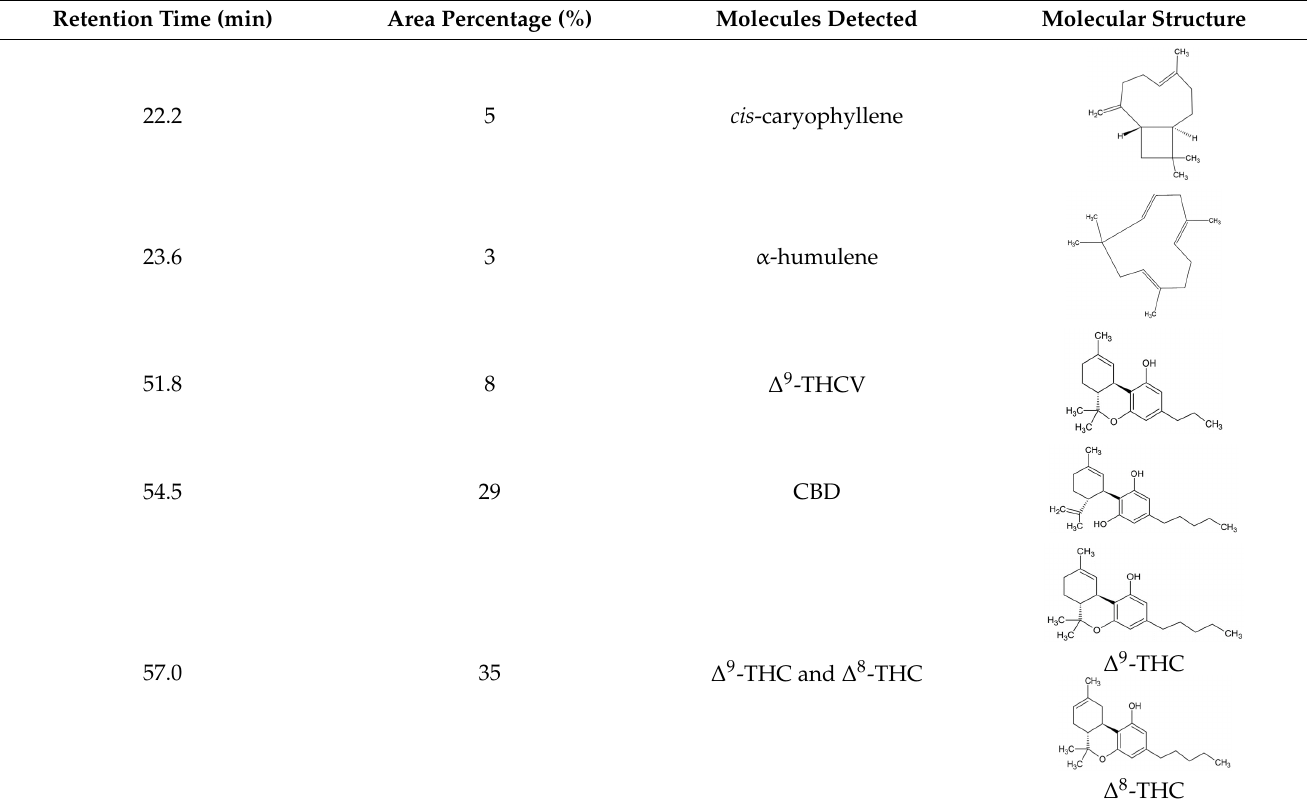
Table 5. Main components identified by GC-MS of cannabis oil obtained from SCCO 2 extraction at optimized conditions (CO 2 pressure: 250 bar, temperature: 43 °C and time: 1.7 h). Retention Time